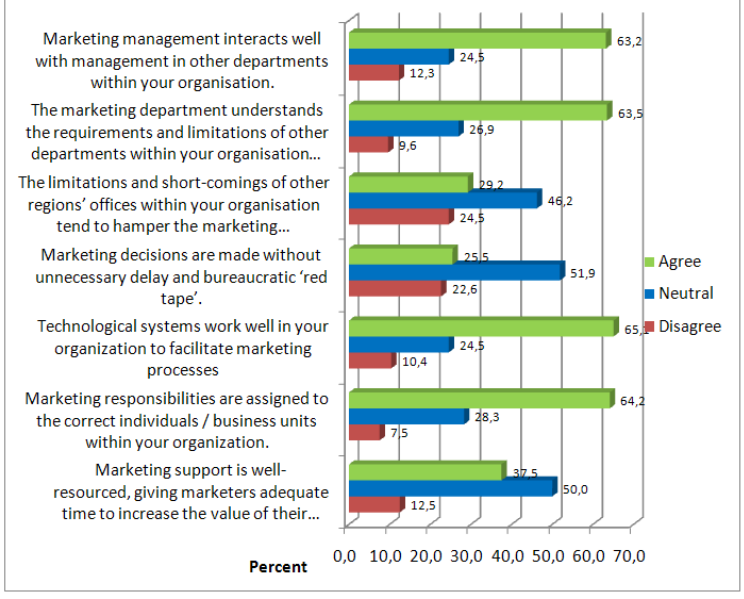
Fig. 9. Respondent scores: process